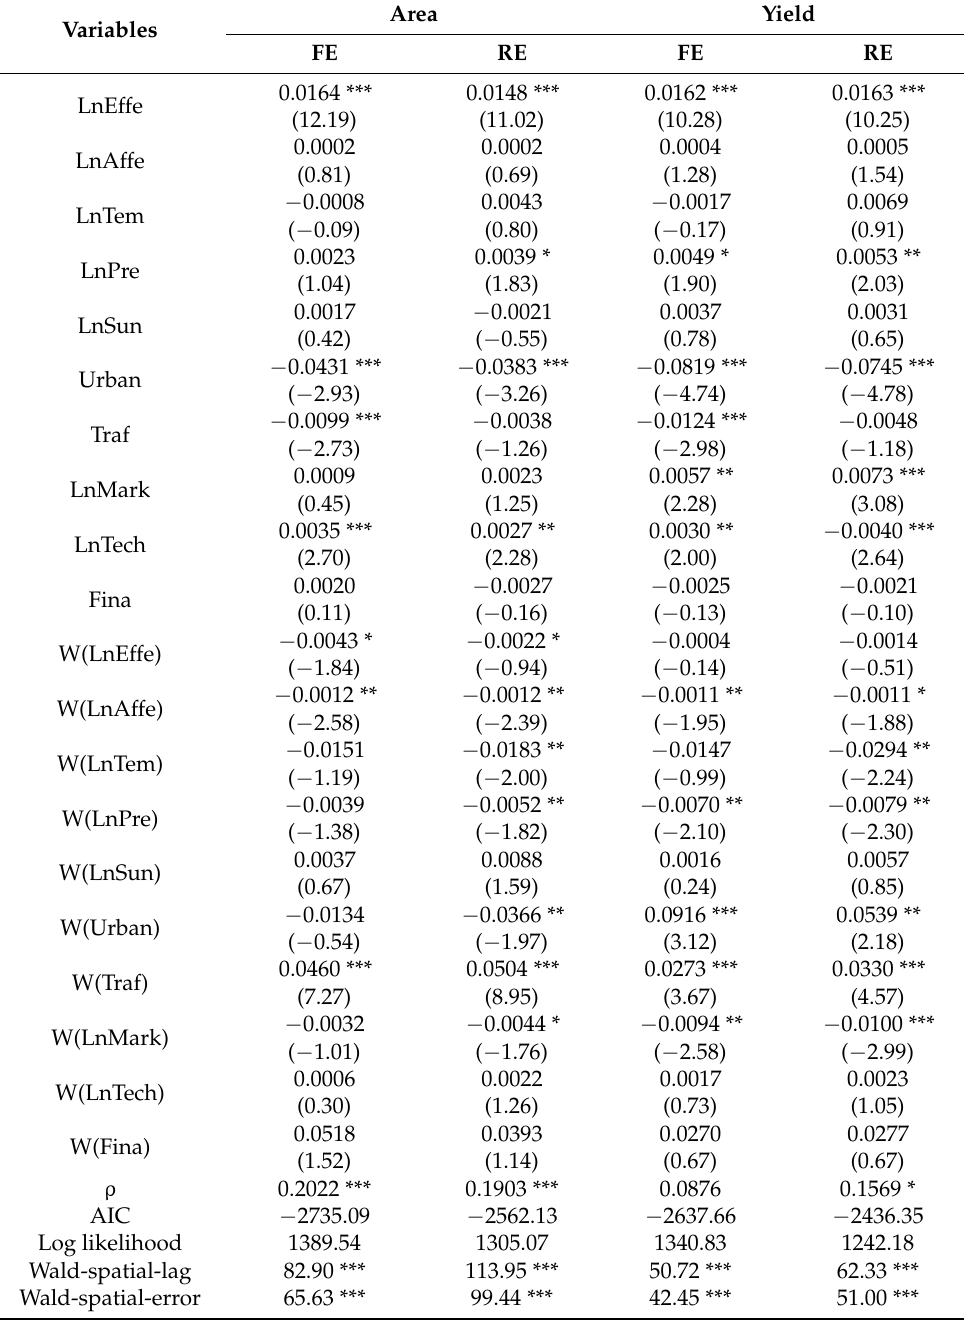
Table 5. Estimation results of spatial Durbin